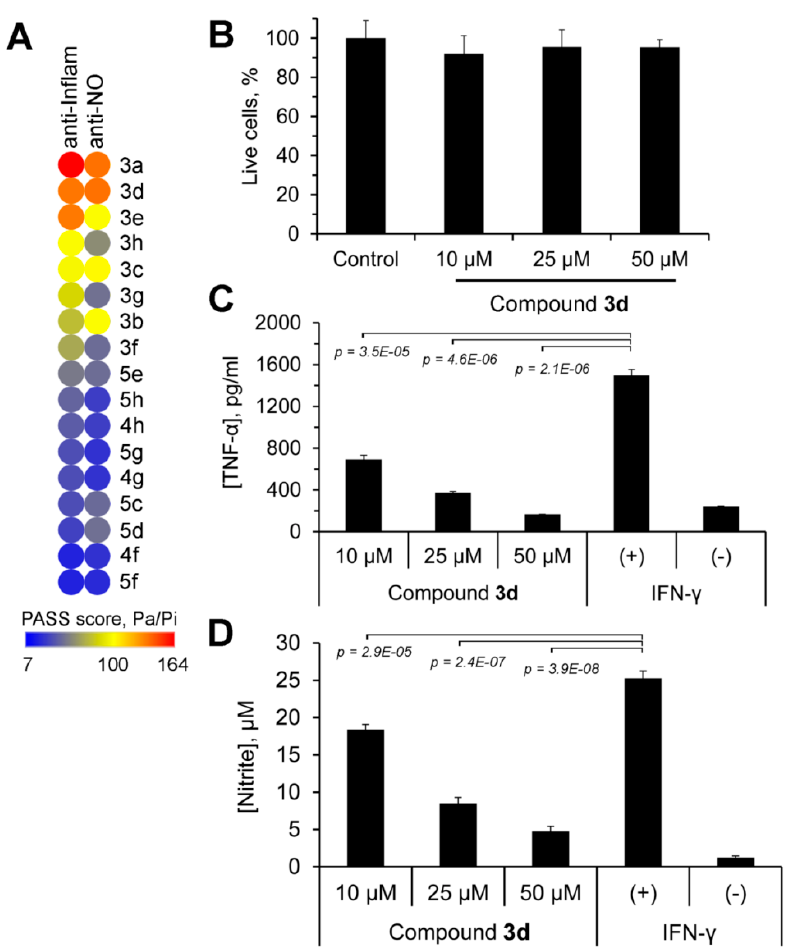
Figure 5. Compound 3d displays significant dose-dependent anti-inflammatory activity in vitro. ( A ) The heatmap showed the probability of the anti-inflammatory potential of novel GA derivatives. The bioactivities of compounds were predicted using the PASS Online platform. Inflammation-related terms “anti-inflammatory” (anti-Inflam) and “nitric oxide antagonist” (anti-NO) were showed. Pa and Pi represent the probability of tested compounds “to be active” or “to be inactive”, respectively. ( B ) Compound 3d is nontoxic to HeLa cells. HeLa cells were incubated in the presence of 3d (10-50 µM) for 24 h followed by analysis of cell viability by MTT assay. ( C ) Compound 3d dose-dependently inhibits production of TNF- α by IFN γ -stimulated RAW264.7 cells. The cells were co-treated by IFN- γ (20 nM) and 3d (10-50 µM) for 24 h, after which the concentration of TNF- α in culture medium was measured using ELISA. ( D ) Compound 3d dose-dependently suppresses production of NO through inflamed macrophages. RAW264.7 cells were co-treated by IFN- γ (20 nM) and 3d (10-50 µM) for 24 h, followed by the measurement of nitrite concentration in culture medium by Griess reaction.